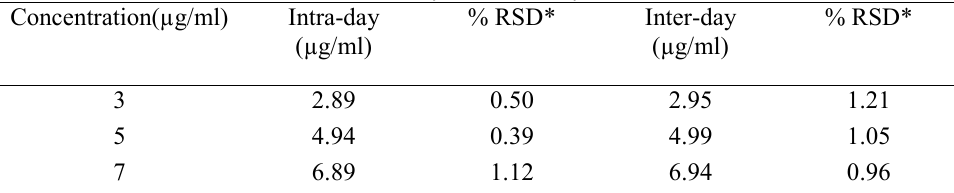
Table 3. Intra-day and Inter-day